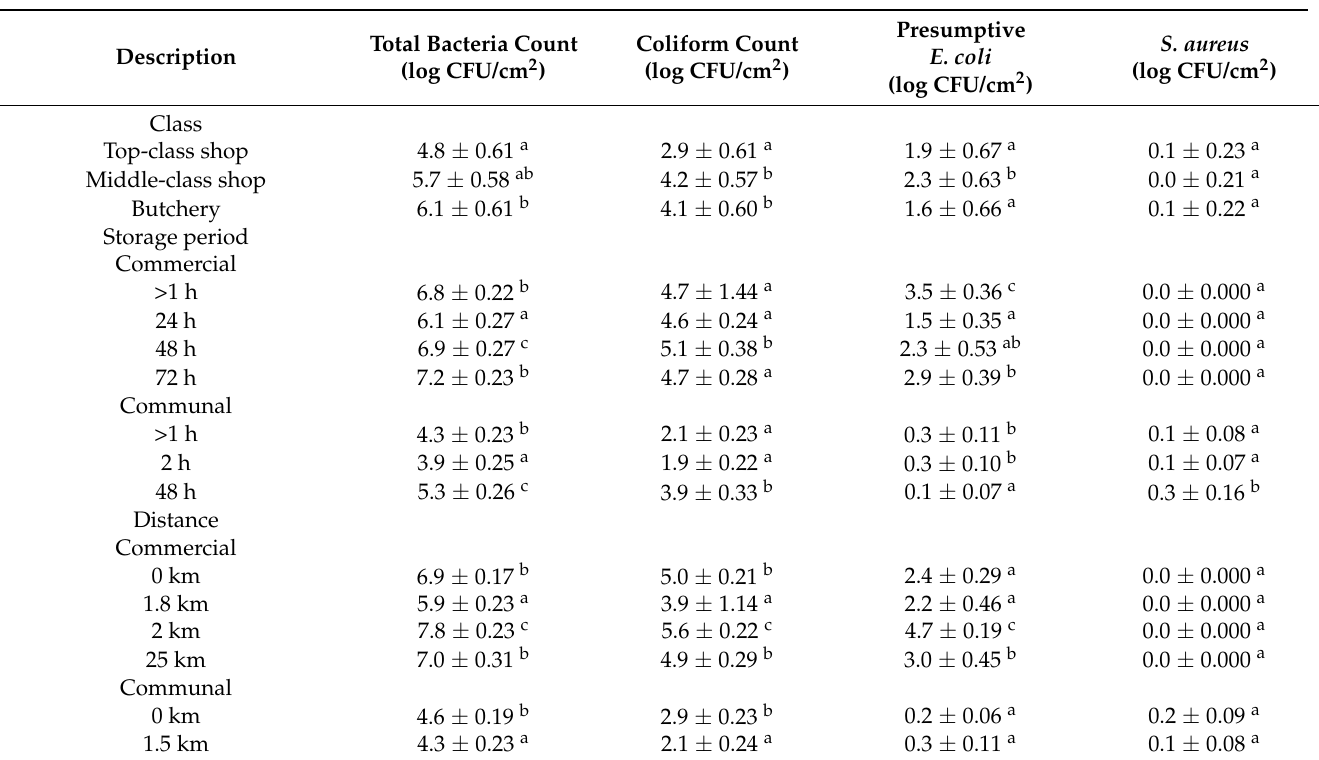
Table 2. Least square mean values ( ± SE) for beef, pork and mutton carcass contamination as affected by shop class, storage period and